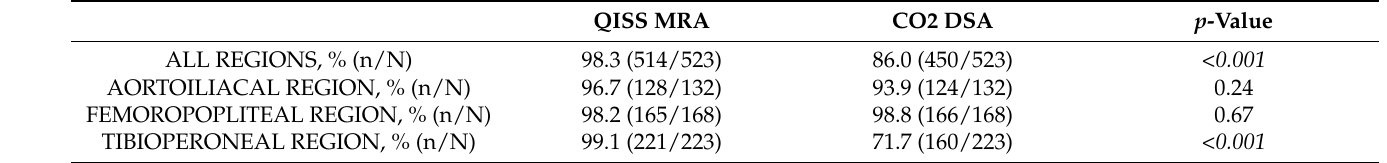
Table 3. Per-artery comparison of interpretability between CO2 DSA and QISS MRA. (CO2 DSA: carbon dioxide subtraction angiography, QISS MRA: quiescent-interval single-shot magnetic reso- nance angiography).